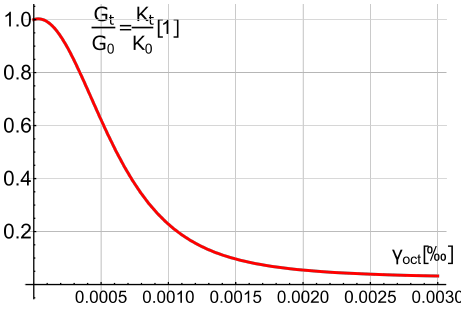
Figure 2. Variation of tangent moduli with octahedral shear strain.